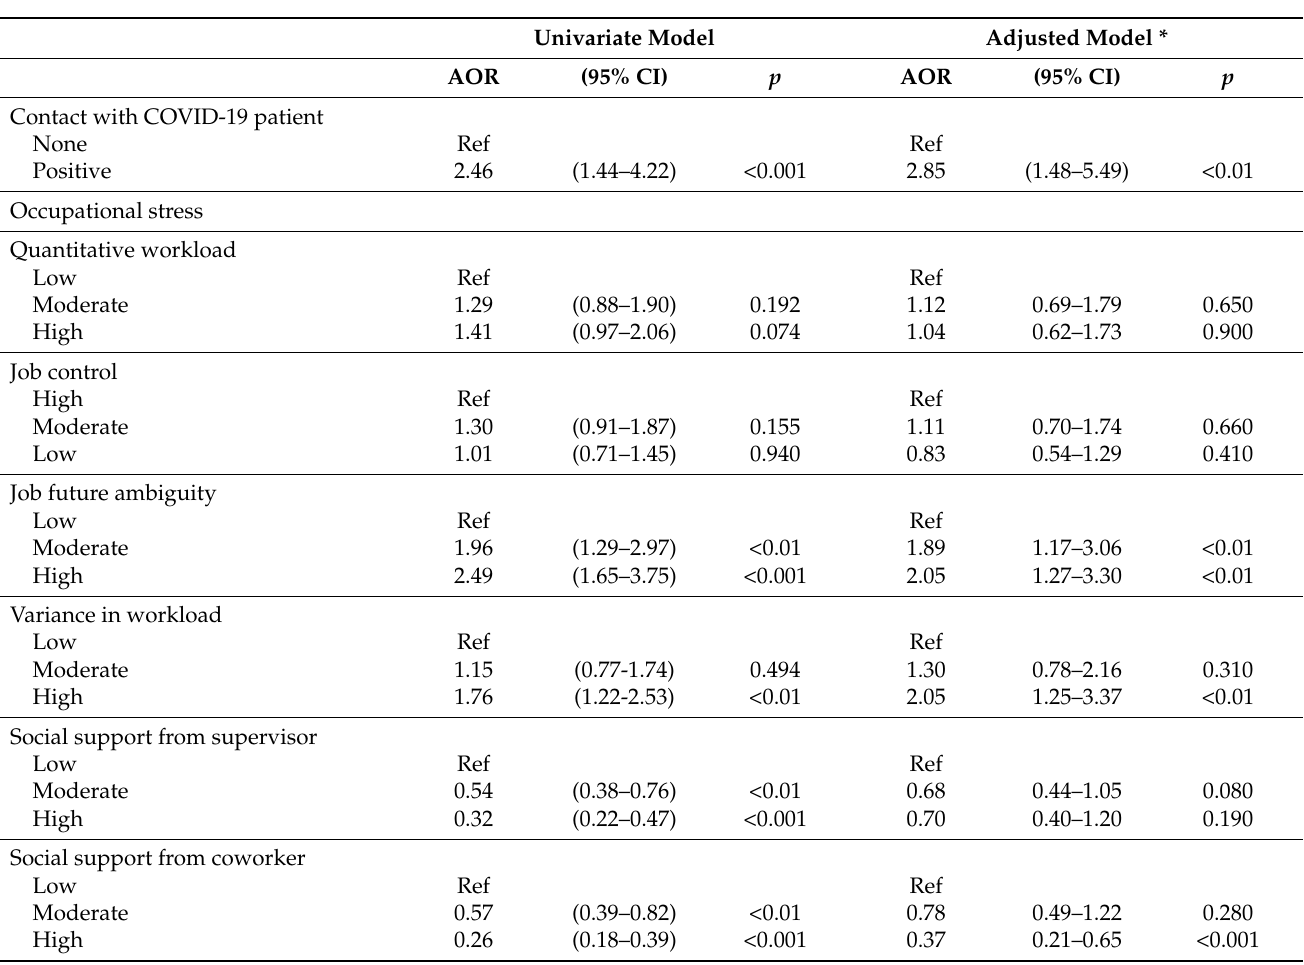
Table 4. Multiple logistic regression analysis of the risk factors related to the ANX group, compared with the non-ANX